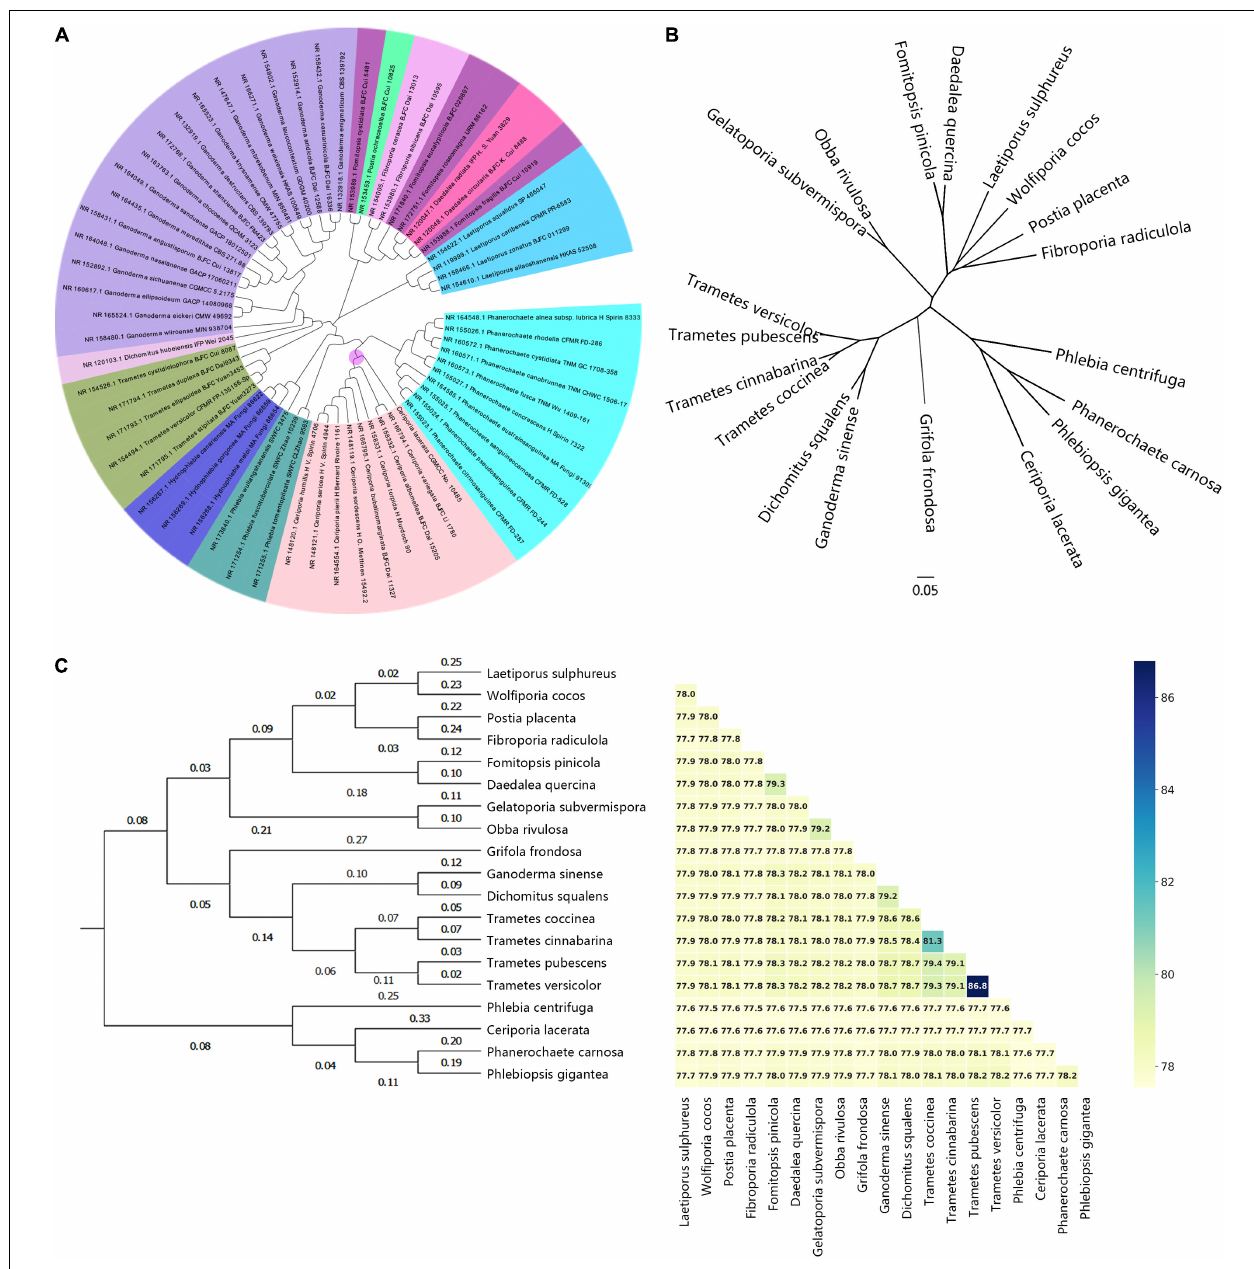
FIGURE 3 | Genome-based phylogenetic analysis of representative strains within the order Polyporales. (A) Phylogenetic analysis based on the ITS sequences from representative TYPE materials from Polyporales and C. lacerata CGMCC No. 10485. Different genera were distinguished with different colors; (B) Unrooted ML phylogenetic tree with single-copy orthologous genes from representative genomes of the order Polyporales based on hidden Markov models. (C) ANI values and ANI-value-based hierarchical clustering. The data matrix was created using species as the independent variable and ANI values between two species as the dependent variable using the group-average method and Euclidean distance as a